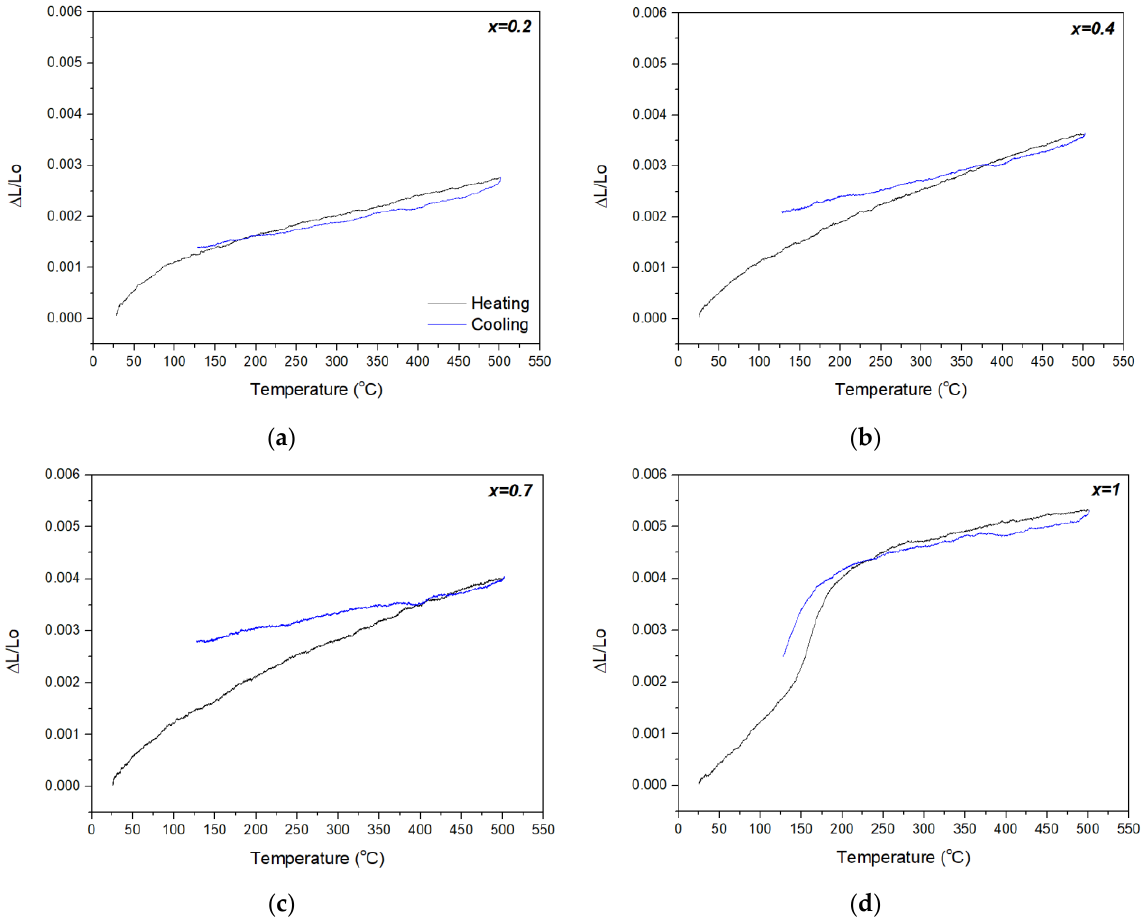
Figure 4. Dilatometric curves of the materials in the family of Al 2− x In x W 3 O 12 : ( a ) x = 0.2; ( b ) x = 0.4; ( c ) x = 0.7; ( d ) x = 1.